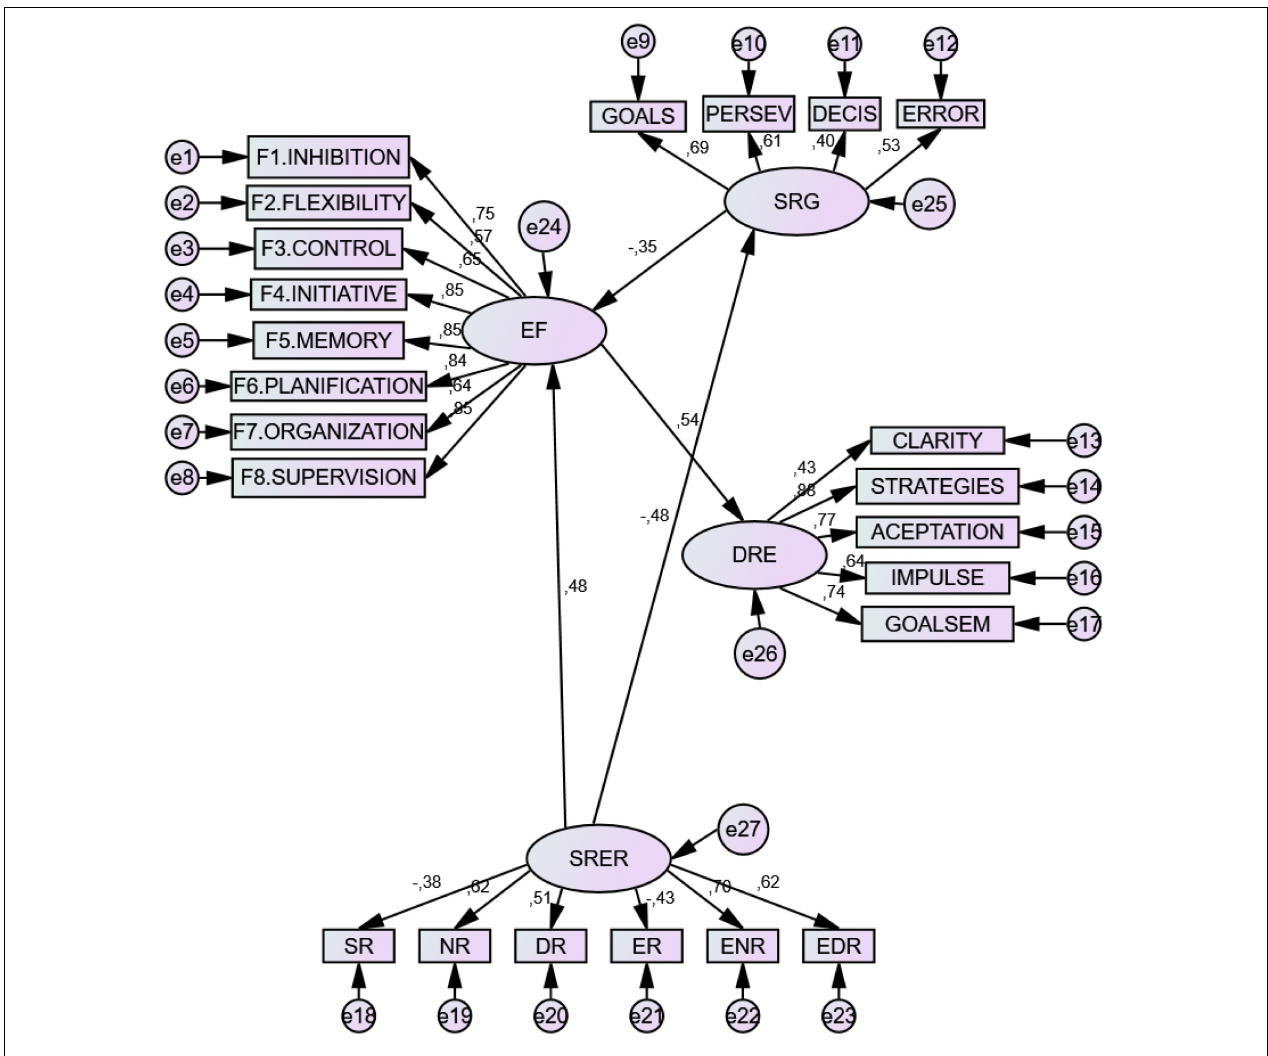
FIGURE 1 | Structural predictive model of relationships. EF, Executive Dysfunction; SRER, Self-regulation vs. External regulation; ERD, Emotion Regulation Difficulties; SR, Self-regulation; SRH, Self-Regulation in Health; NRH, Non-Regulation in Health; DRH, Dys-Regulation in Health; ERH, External-Regulation in Health; NRH, External Non-Regulation in Health; EDRH, External Dys-Regulation in Health. TABLE 8 | Effect of low–medium–high levels of the independent variable executive functions (EF) on SR. Level of the independent variable EF Mean of the dependent variable SR